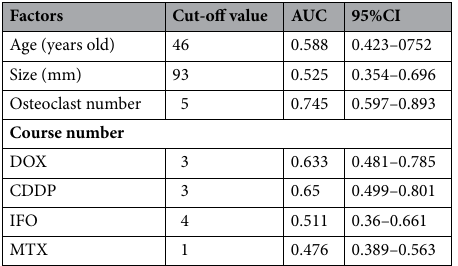
Table 1. The optimal cut-off values of factors by ROC curve. DOX: doxorubicin, CDDP: cisplatin, IFO: ifosfamide, MTX: methotrexate, ROC: receiver operating characteristics, AUC: area under curve, CI: confidence